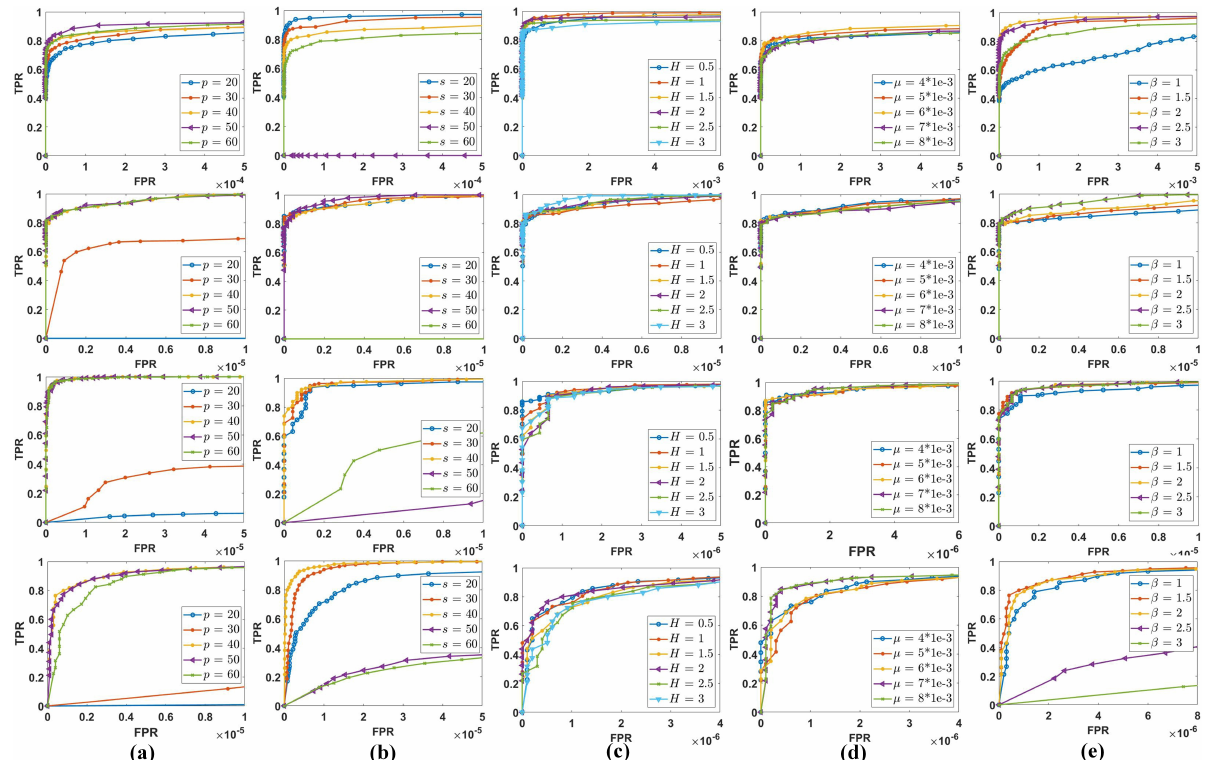
Figure 5. ROC curves are formed with different parameters. ( a ) The first column depicts the curves of different patch sizes p . ( b ) The second column depicts the output of different sliding steps s . ( c ) The third column shows the influence of the tradeoff factor λ . ( d ) The fourth column shows the results of different penalty factors µ . ( e ) The fifth column shows the result for different β values. Each row represents a different parameter in the same